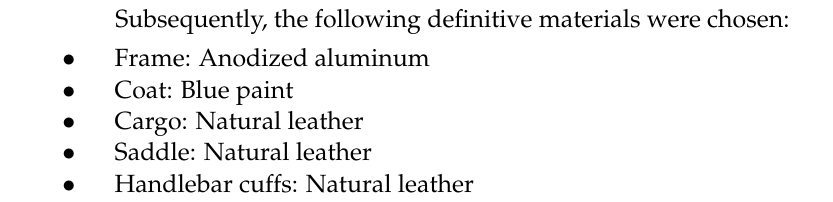
Figure 13. Design engineering: orthogonal projections.